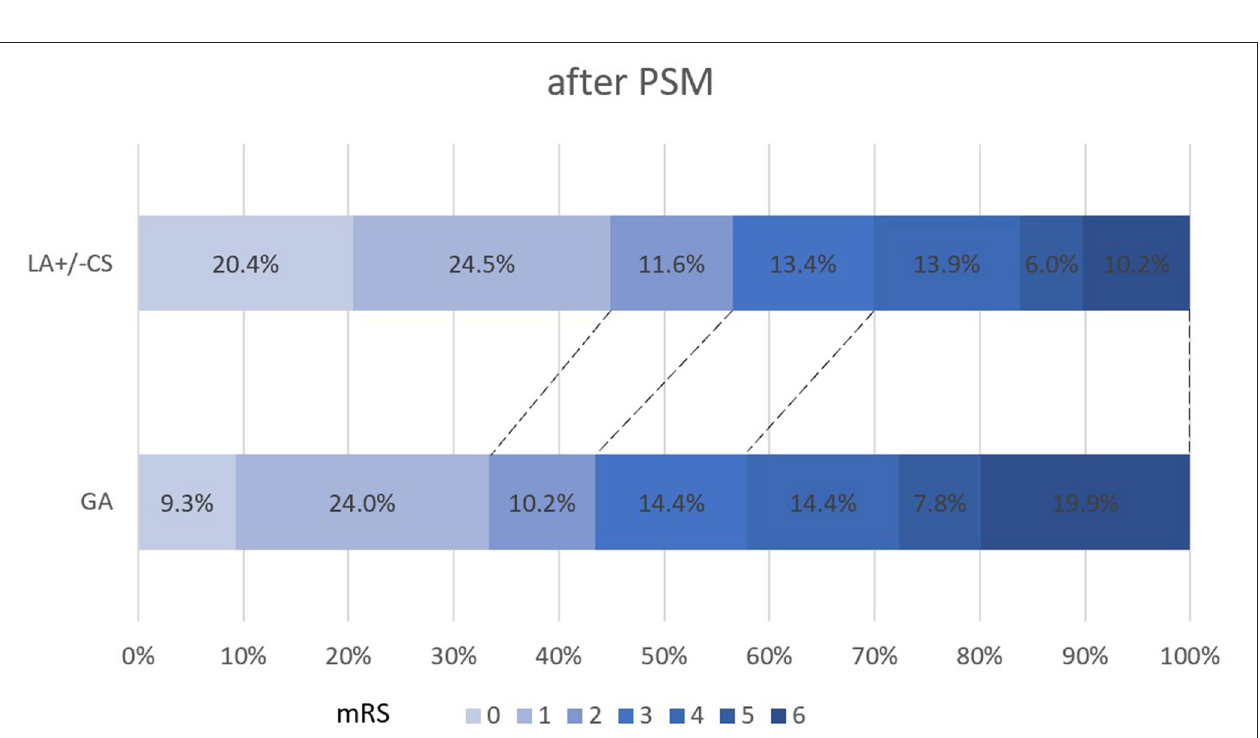
FIGURE 3 | Shift on the 90-day mRS score stratified by LA ± CS and GA after PSM. PSM, propensity score matching; mRS, modified Rankin Scale; GA, general anesthesia; LA, local anesthesia; CS, conscious sedation.